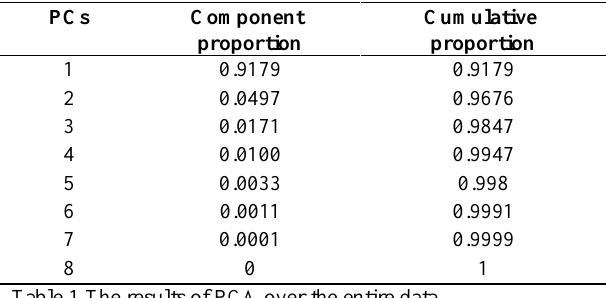
Table 1 The results of PCA over the entire data